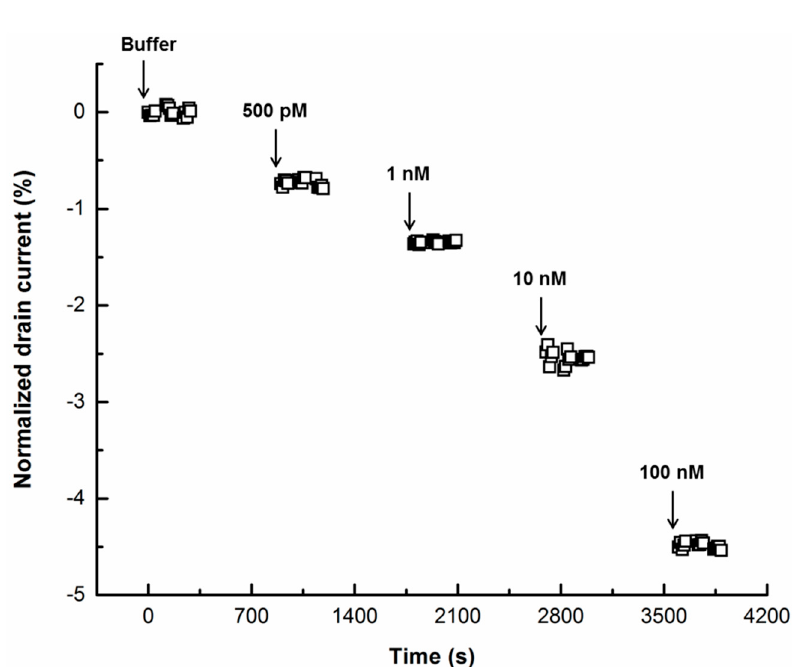
Figure 6. Kinetic measurements of prostate-specific antigen at different concentrations using as-prepared devices at a fixed gate voltage ( − 300 mV).